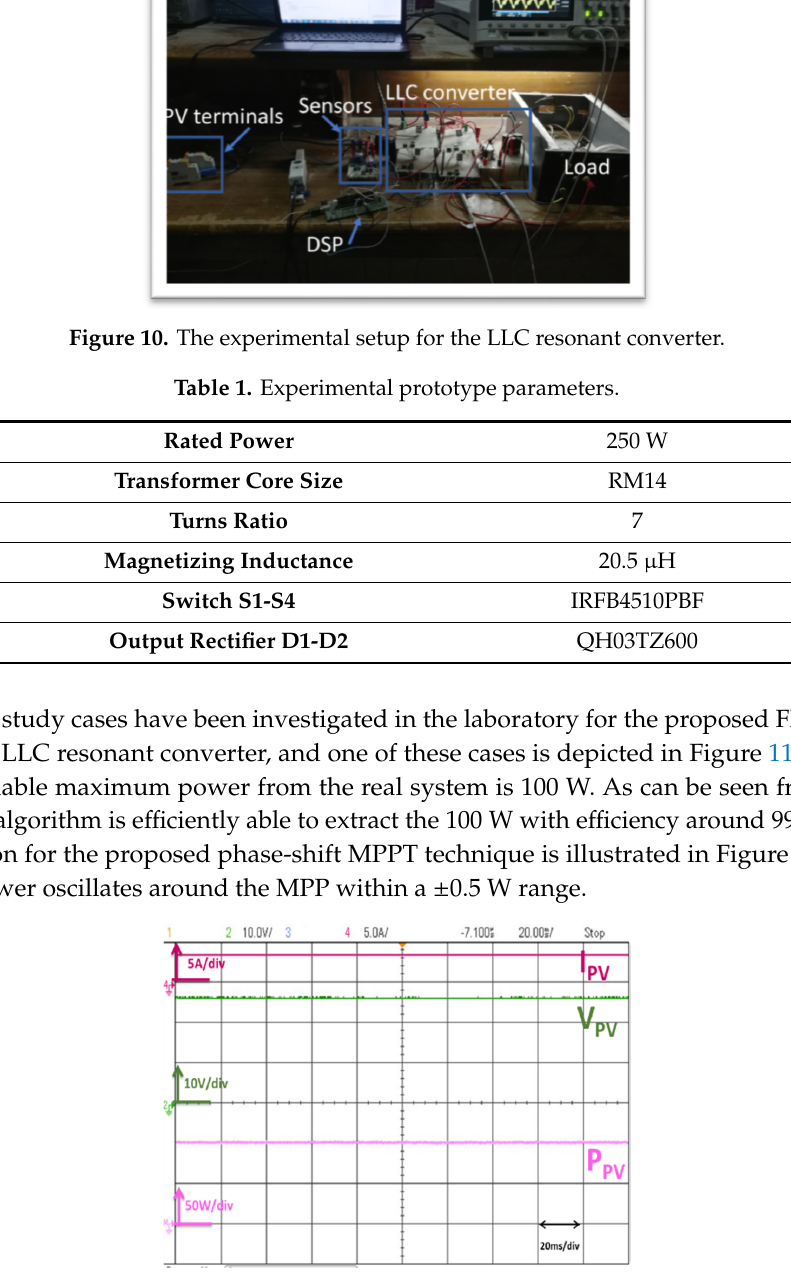
Figure 12. Steady state PV power oscillations for the proposed fixed-frequency predictive MPPT (Ch2 (green) is PV voltage, Ch4 (pink line) is the PV current), the PV extracted power (lavender line). Another experimental case study is depicted in Figure 13. In this study case, the available maximum power from the real system is 115 W. As can be seen from the graph, the proposed algorithm is efficiently able to extract the 115 W effectively.